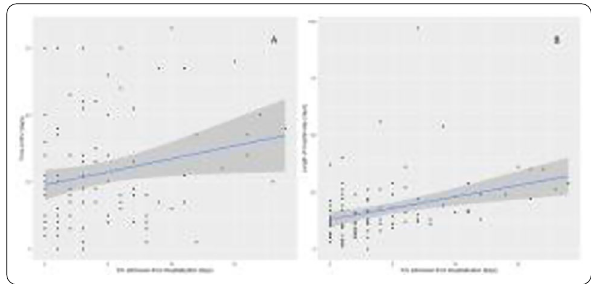
Results: 322 patients were included. mean age was 55 13 years and ± the gender ratio (H/F) was 1.42. Means of SAPS II and APACH scores were respectively 23 8 and 7 4. The most frequent comorbidities ± ± were obesity (49.7%), diabetes (37.3%) and hypertension (36,6%).